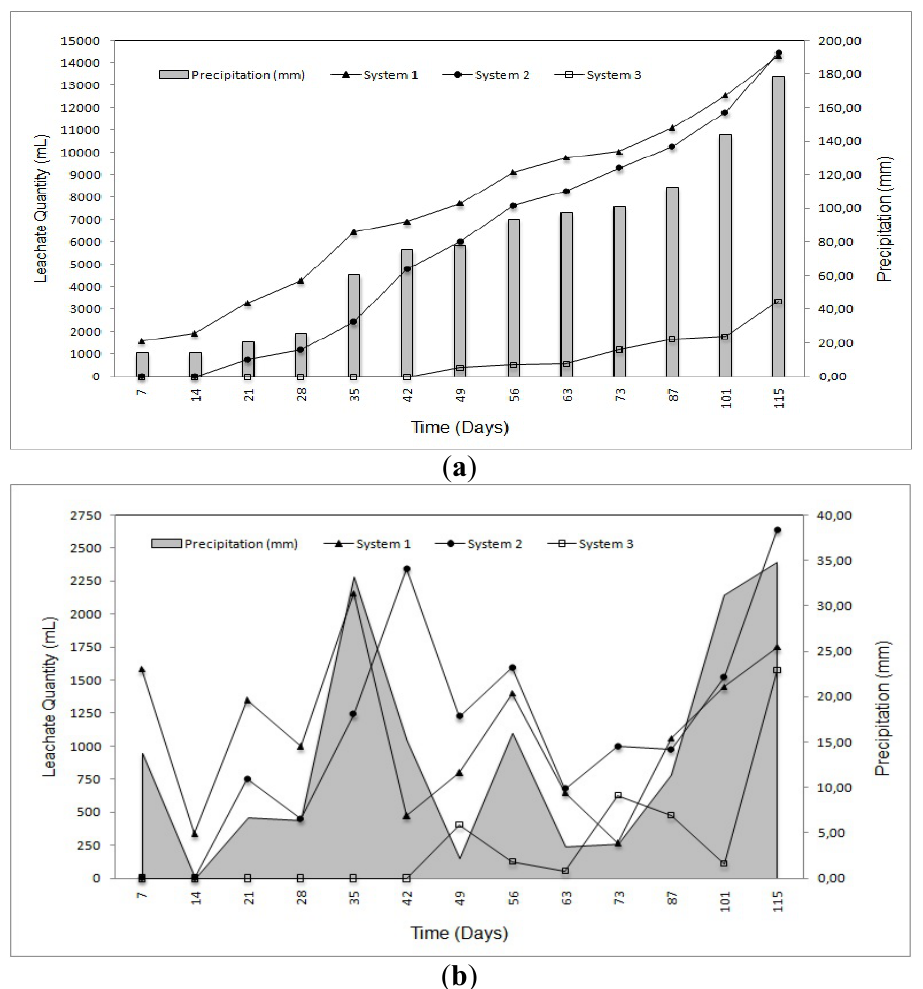
Table 4. Comparison of the leachate characteristics in system 1 with different leachates. Parameters